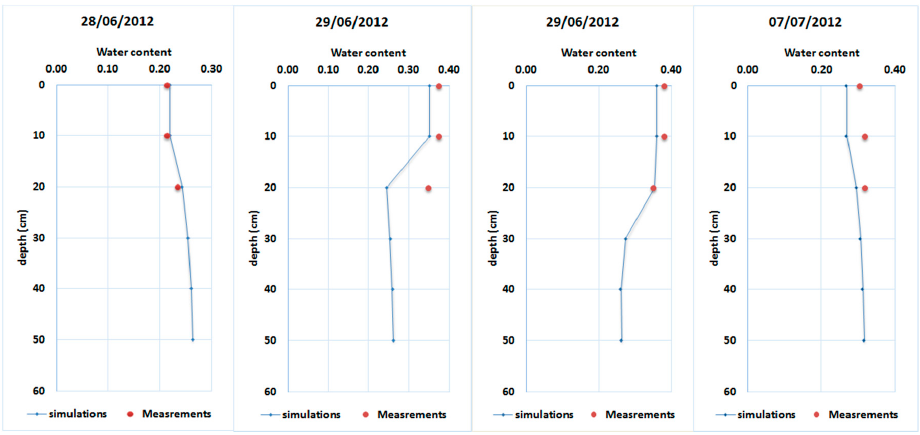
Figure 8. Variation of soil moisture (cm 3 /cm 3 ) within the soil profile measurements and simulations based on Ross model before, during and after an irrigation event on June 29, 2012.